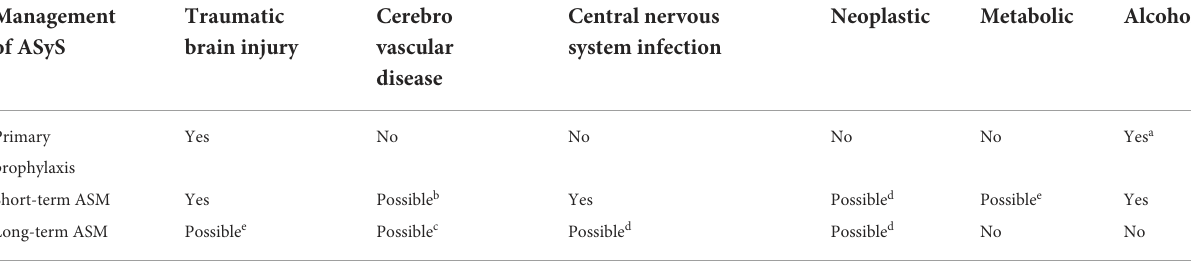
TABLE 2 Antiseizure management for acute symptomatic seizures